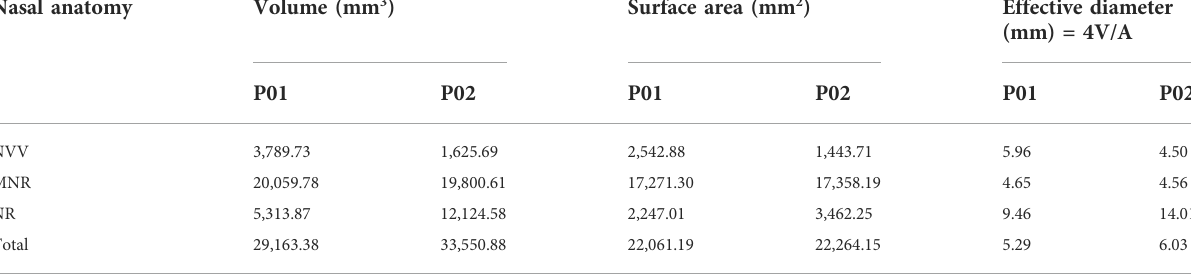
TABLE 2 Effective diameter.